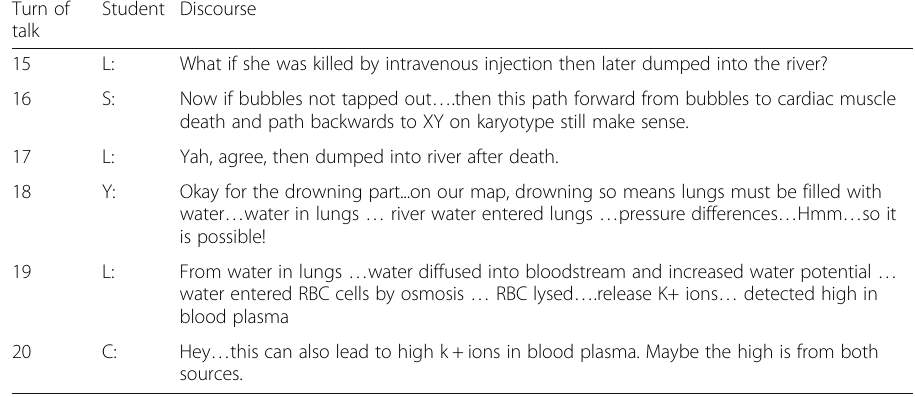
Table 9 Excerpt 3: A segment of discourse from group F ’ s discussion (lines 15 to 20) Turn of